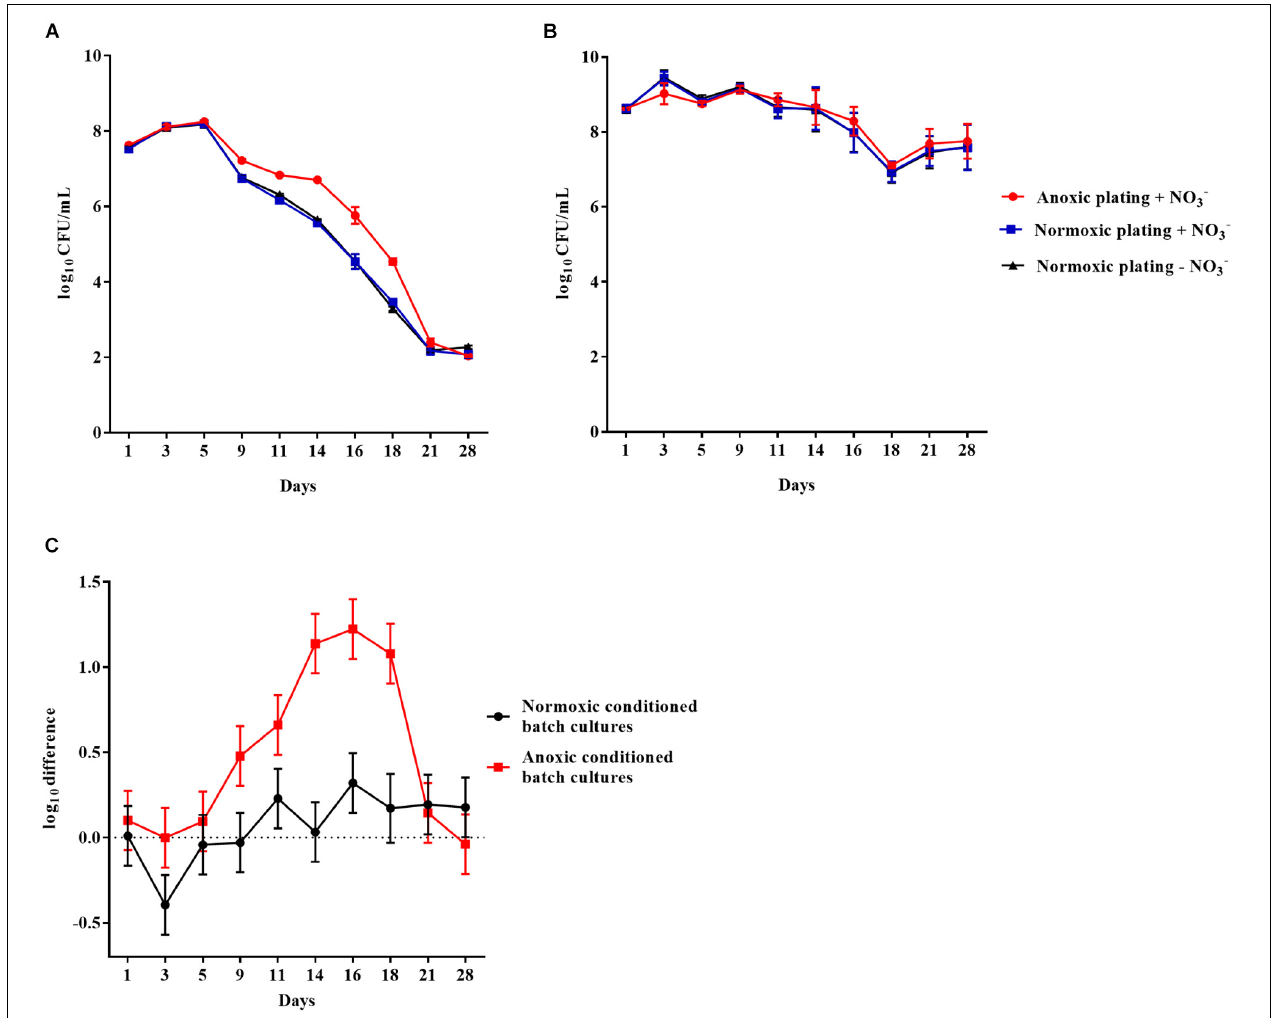
FIGURE 4 | An oxygen intolerant subpopulation of Pseudomonas aeruginosa (PAO1) was generated in the planktonic batch cultures. Normoxic and anoxic colony forming units per milliliter (CFU/mL) of PAO1 over 28 days from anoxically (A) and normoxically (B) conditioned batch cultures. Symbols with error bars indicate the mean ± SEM ( n = 4). ± NO 3 - refers to the addition of 10 mM KNO 3 to LB agar plates. The log difference (C) represents the difference in mean log CFU/mL between plating methods from the normoxically and anoxically conditioned batch cultures, respectively. The log difference was significantly higher ( p < 0.0001, linear regression) in the anoxically conditioned batch cultures than the normoxically conditioned. Symbols with error bars indicate the mean + confidence